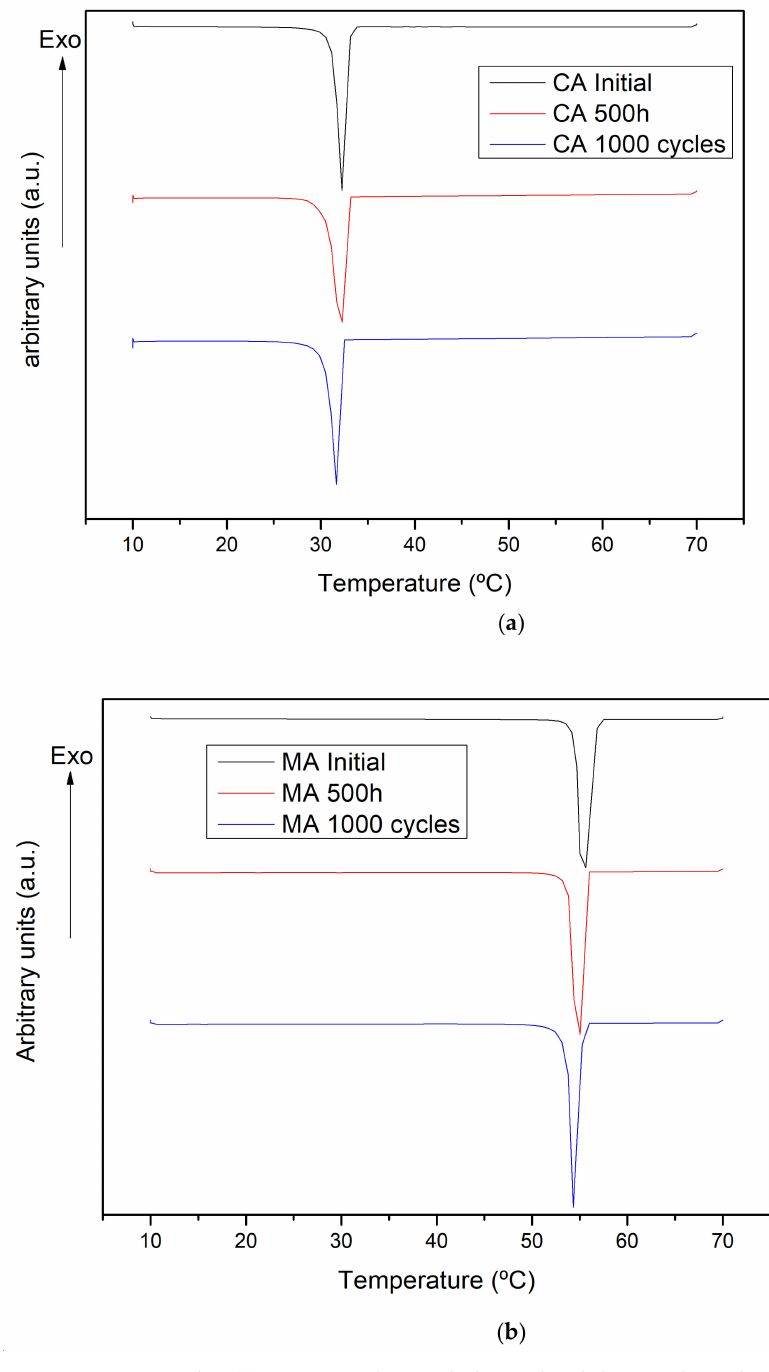
Figure 6. DSC results: ( a ) Capric acid: initial, thermal stability 500 h, cycling stability 1000 cycles ( b ) Myristic acid initial, thermal stability 500 h, cycling stability 1000